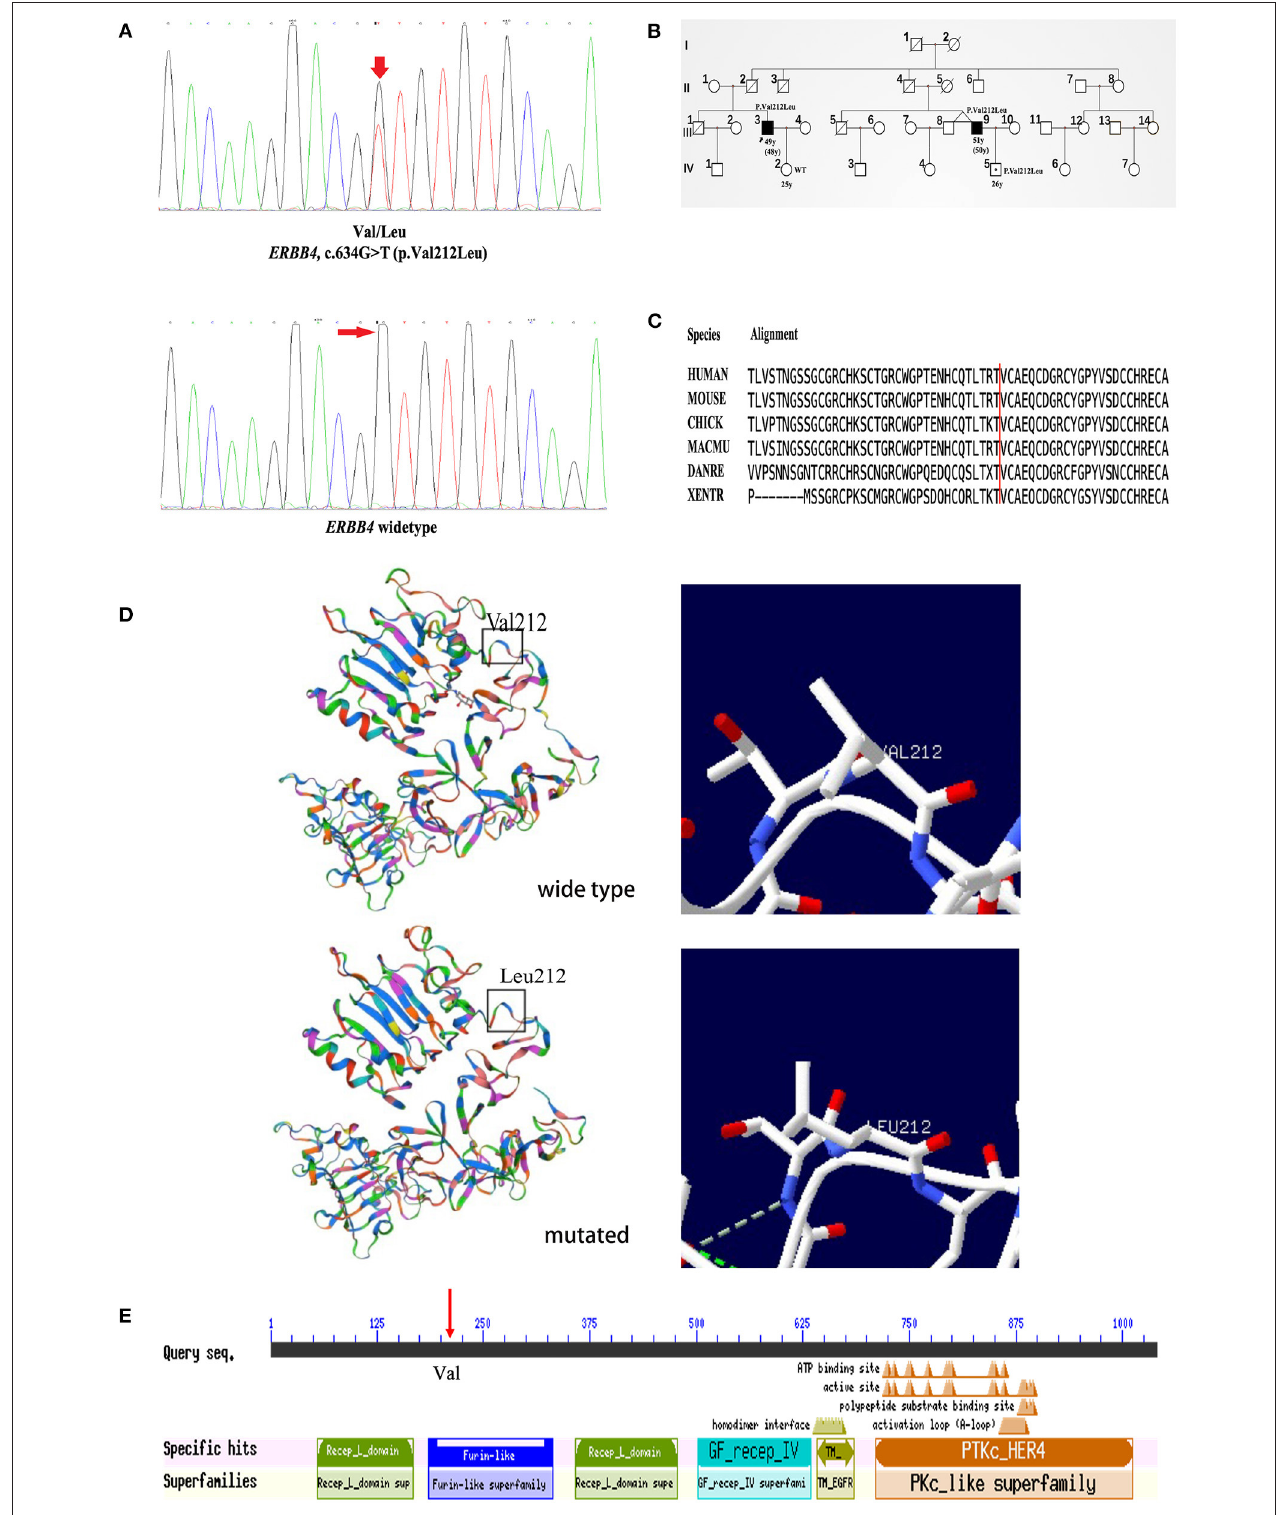
FIGURE 2 | Genetic analysis of the pedigree carrying the ERBB4 p.Val212Leu mutation. (A) The chromatograph of ERBB4 p.Val212Leu mutation and its normal control. (B) Pedigree structure of family carrying the ERBB4 p.Val212Leu mutation (III3 and III9: Affected person carrying mutant gene. IV5: Unaffected person carrying mutant gene). (C) The ERBB4 p.Val212Leu residue is highly conserved across multiple species. (D) The structures of wild-type ERBB4 and mutated ERBB4 . (E) The ERBB4 protein domain and the mutation site were located in the Furin-like cysteine-rich region (red arrow).